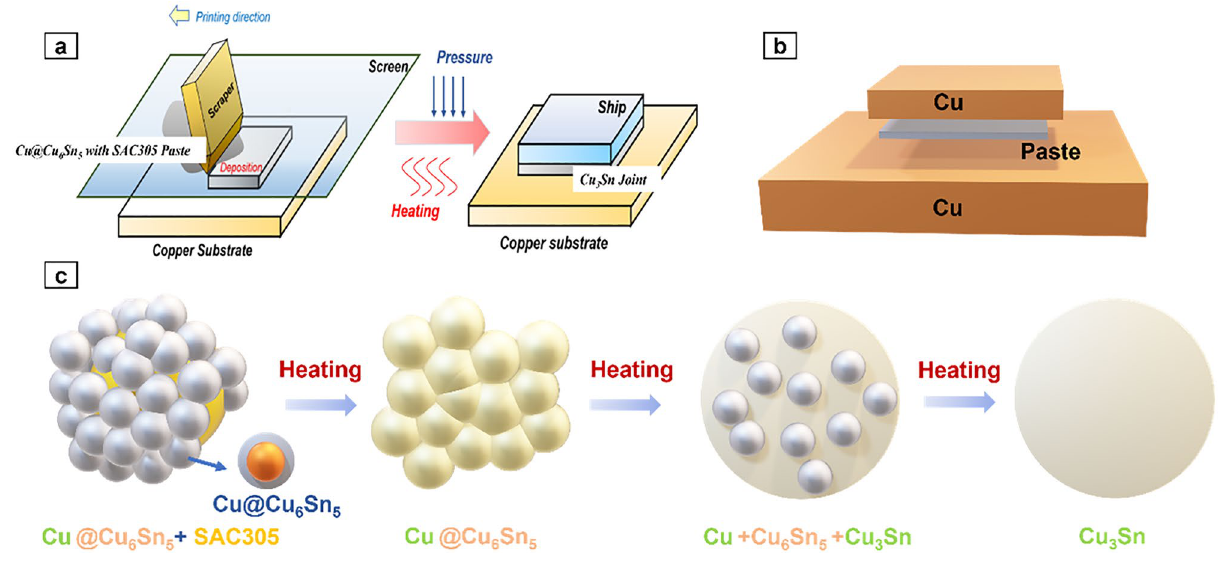
Figure 3. ( a ) The paste is screen-printed on the surface of a Cu substrate and reflowed at 280 °C under a pressure of 10 MPa for 60 min. ( b ) Transient liquid phase (TLP) bonding. ( c ) Schematic diagram of solder paste changes during heating. During the heating of the solder paste, Cu 6 Sn 5 reacts with Cu to form Cu 3 Sn. In the early stage of reaction, the diffusion of Cu element dominates the reaction, and in the late stage, the diffusion of Sn atom dominates the reaction. This reaction process will cause the volume shrinkage of the joint, so the auxiliary pressure of 10 MPa shall be maintained during